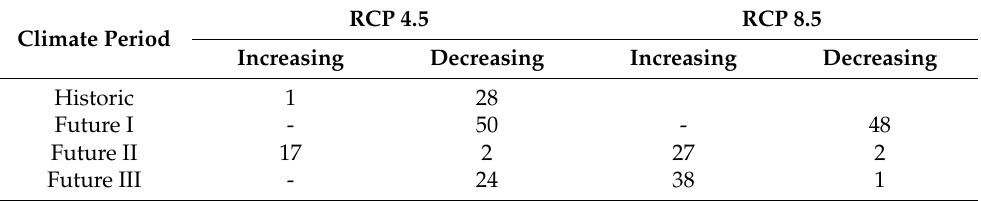
Table 5. Number of subbasins with increasing or decreasing